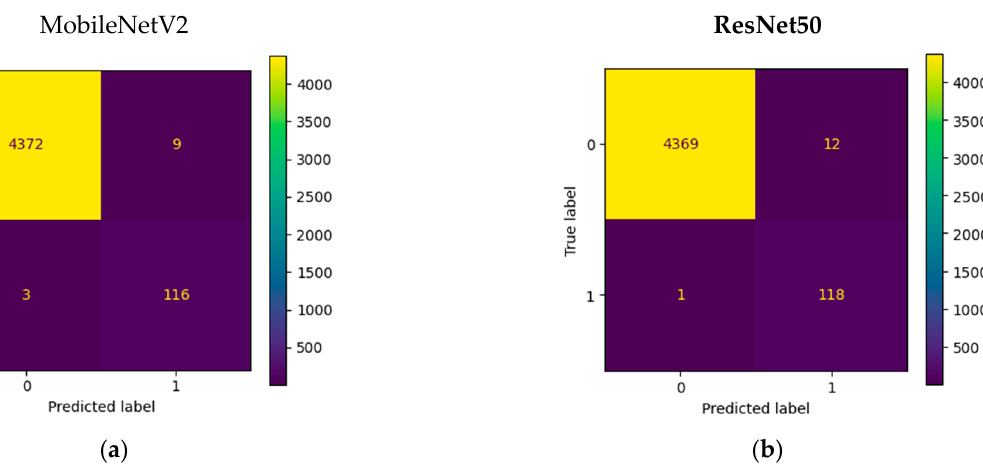
Figure A2. Deep Learning approach confusion matrixes; ( a ) MobileNetV2 model; ( b ) ResNet50 model.